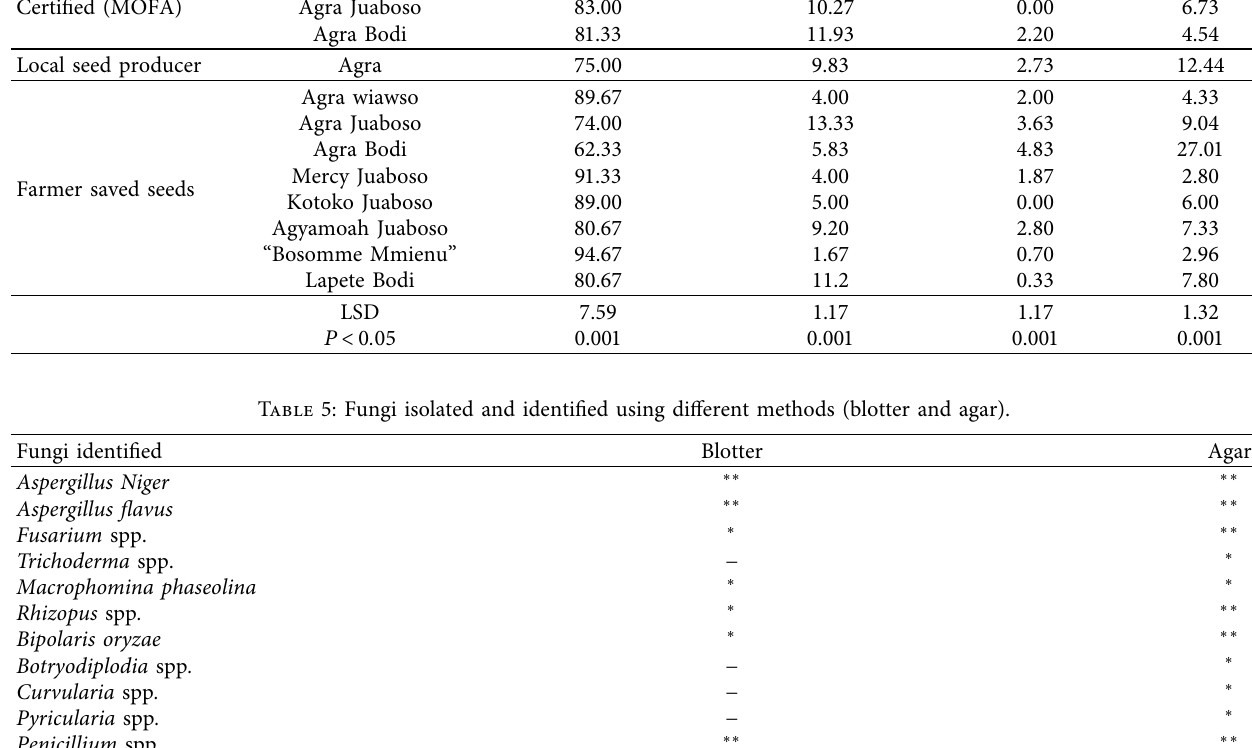
Local seed producer